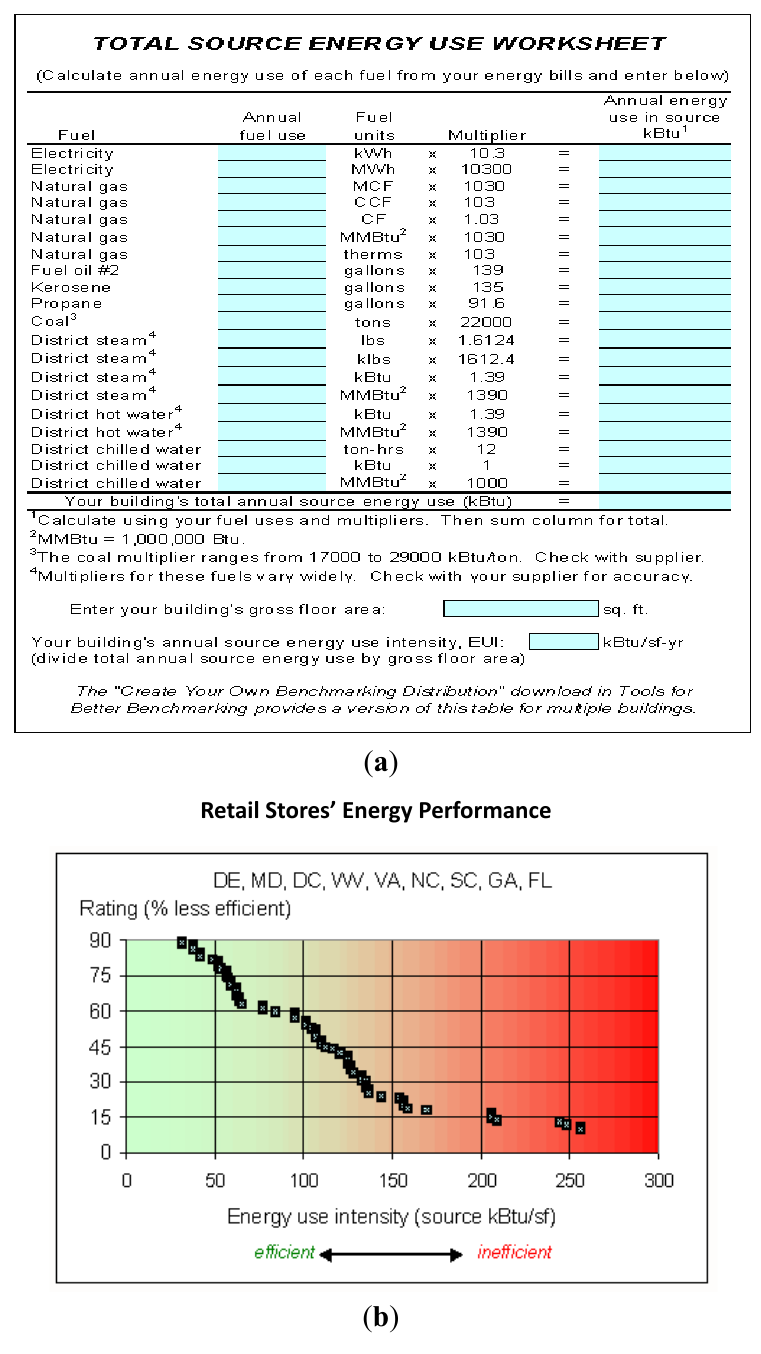
Figure 9. EUI rating method in the comparison experiment [18]: Oak Ridge National Laboratory promoted the method to estimate energy-saving potentials by building EUI rating. EUI value is obtained by input data of energy usage as shown in ( a ); using retail stores’ energy performance as shown in ( b ), energy use and cost reductions can be